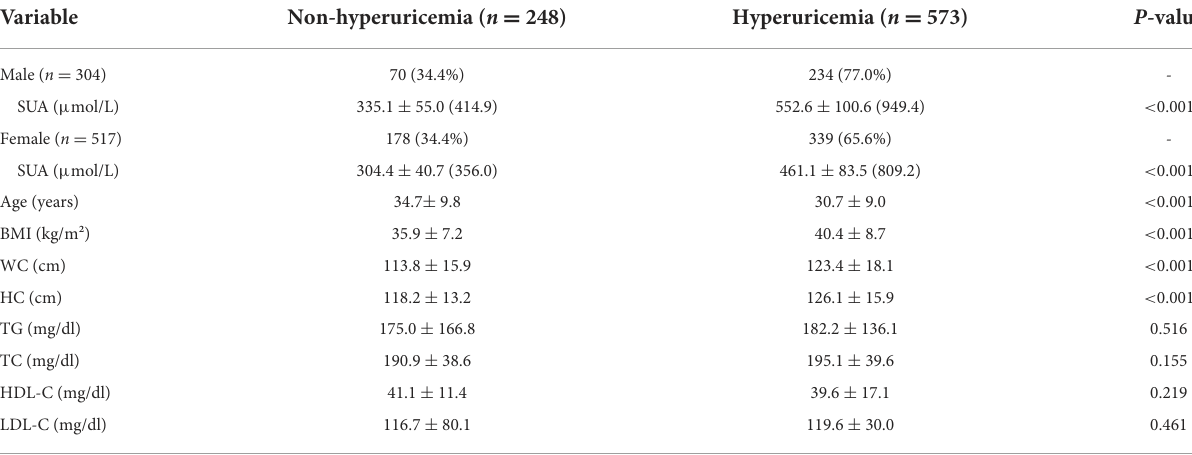
TABLE 2 Comparison of baseline characteristics between non-hyperuricemia and hyperuricemia subjects. Variable